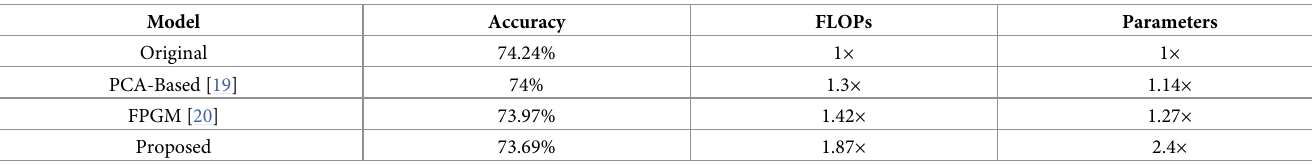
Table 10. Comparison of VGG-19 on